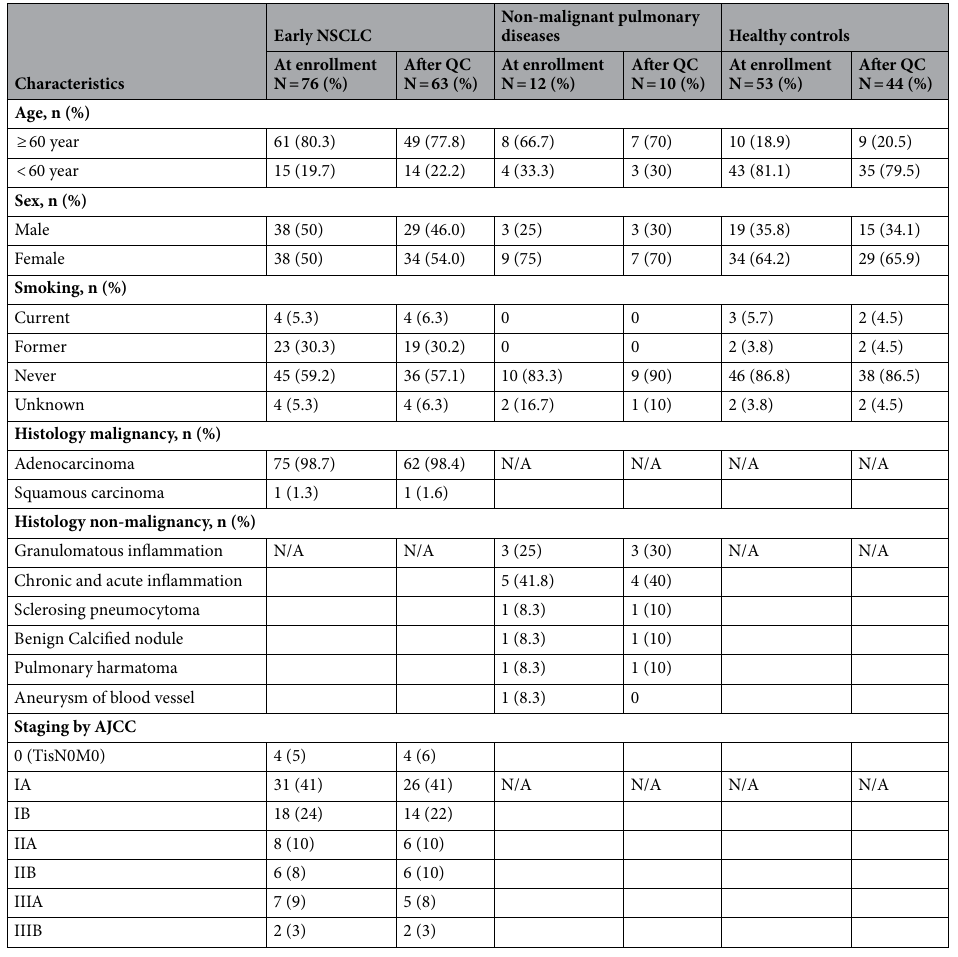
Table 1. Demographics and disease characteristics of patients with early-stage NSCLC, non-malignant pulmonary diseases, and healthy controls at study enrollment and after quality control (QC) assessment. QC quality control, N/A